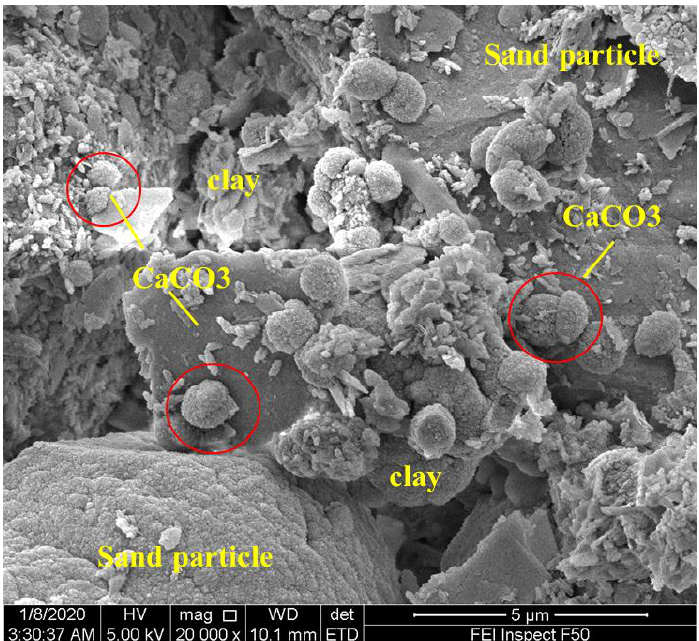
Figure 7. SEM image of treated sample D3, magnification = 20,000×.